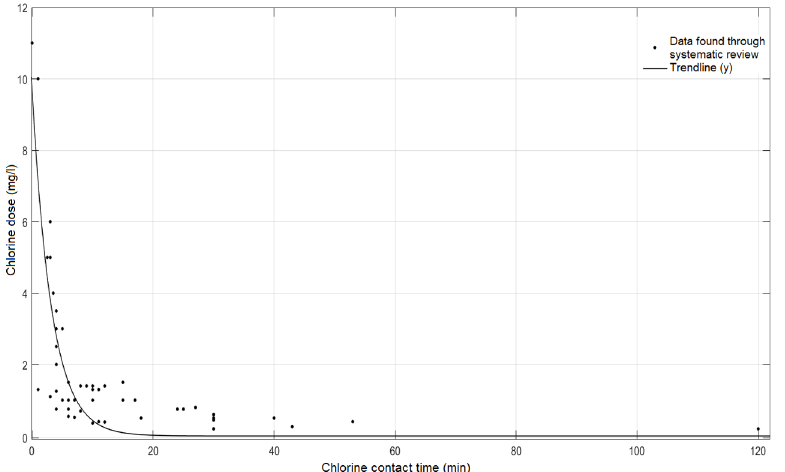
Fig 2. Lethal chlorine doses for killing 100% of schistosome cercariae. All studies used motility as a measure of death, and recorded the time at which all cercariae were motionless. Chlorine doses are plotted here because most studies did not report the residual chlorine concentrations. Species are listed in Table 6 and shown in S3